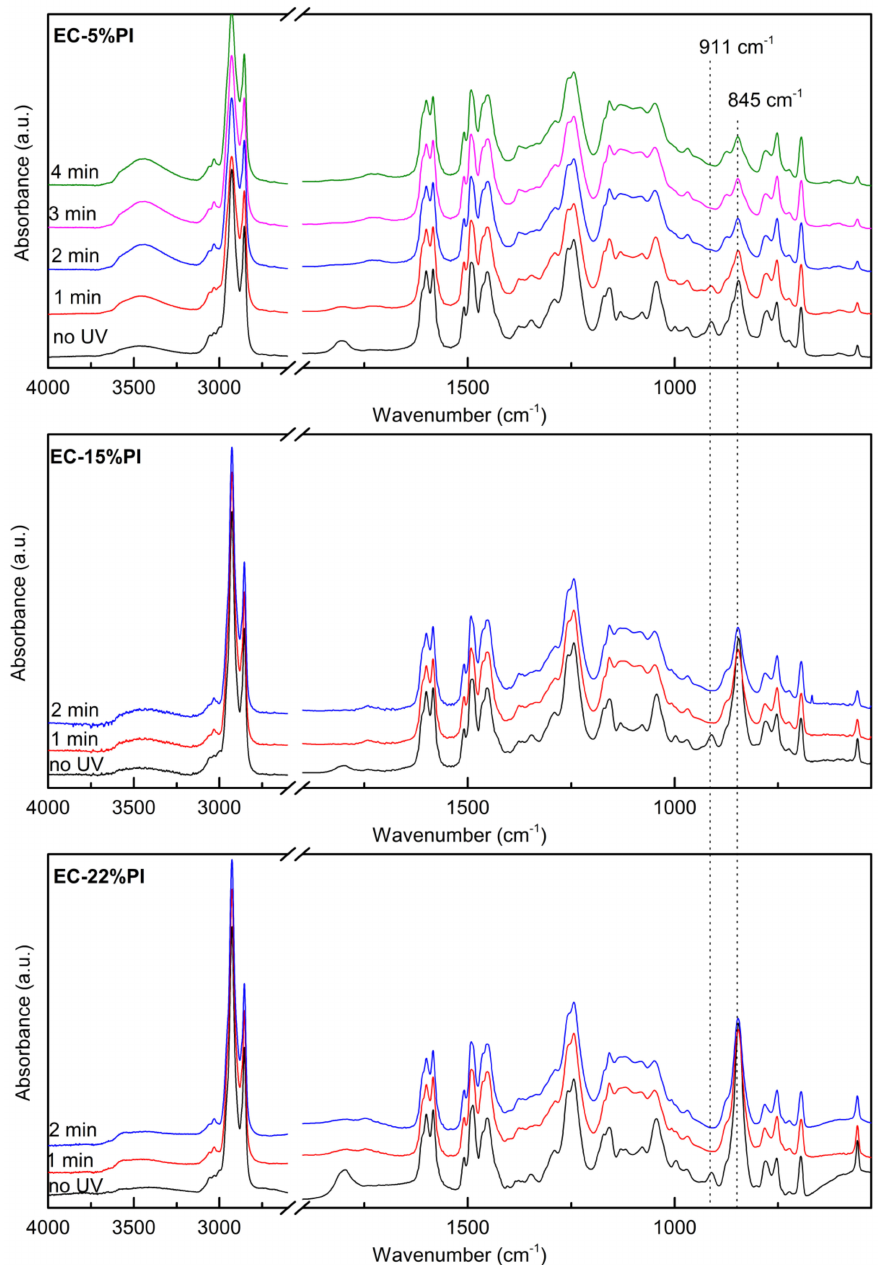
Figure 7. FT-IR spectra of the EC-5%PI, EC15% PI and EC-22%PI resins before and after di ff erent times of exposure to UV radiation with a 100 mW cm − 2